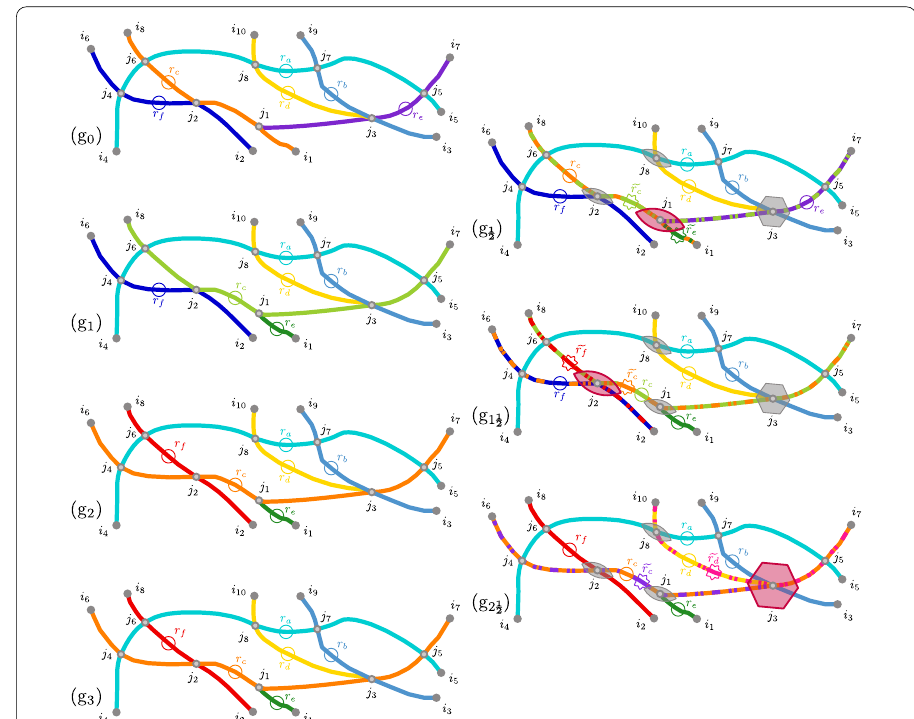
Fig. 5 Single-junction-switch Metropolis algorithm for configurations of streets: the frames ( g ⋆ ) show how this algorithm may evolve from the configuration of streets on street map ( m ′ ) to the one on street map ( m ) from the notional example in Fig. 1. The subscript of each frame label indicate the generation time. The figure reads from top to bottom. It actually separates generated configurations of streets from intermediate computational steps in two complementary ways: it shifts (resp. epochs) the formers to the left column (resp. with integers) and the latters to the right column (resp. with half-integers). The right frames display more information. In particular each switchable junction is marked with an extended regular polygon whose the corners (sides) enumerate its maximum matchings (see Fig. 4): when the polygon is in grey, the junction is resting; when the polygon is in red and notably bigger, the junction is switching. As for the state-of-the-art construction paradigm in Fig. 3, we attribute to each street a particular colour. In clear contrast, however, all streets are here fully constructed. The streets in dashed lines are not under construction but instead under challenge as follows. The dashing actually indicates coexistence of old streets with new ones. Each old street keeps its colour, its circle mark, and its label. Each new street emerges with a new color, a wavy-circle mark, and a tilded label. The new streets result from the new street layout at the switching junction. This change leads so to a new configuration of streets ν that competes with the old one µ . This is the actual ongoing challenge. The Metropolis algorithm resolves such challenges by either accepting or rejecting change µ → ν with an acceptance ratio A (µ → ν) in an optimal way. After a sufficient number of generations, the configurations of streets reach a prescribed statistical equilibrium—provided the equilibrium is sustainable. Our prescribed statistical equilibrium follows from the assumption that self-organized urban street networks are statistically self-similar. It is a Boltzmann-like distribution with a total amount of surprisal (information) instead of energy and the scaling as equilibrium parameter (see formula (16)). Our odds of accepting or rejecting new configurations of streets favour the less surprising ones (see formulae (23) and (30)). The algorithm goes like this (see “Informal implementation” section). Note first that only the four junctions j 1 , j 2 , j 3 , and j 8 are actually switchable: junction j 3 has Y 3 = 6 maximum matchings (see Fig. 4c); junctions j 1 , j 2 , and j 8 have Y 1 = Y 2 = Y 8 = 2 maximum matchings (see Fig. 4a, b); the remaining junctions j ◦ have obviously Y ◦ = 1 maximum matching. So each move will first choose randomly one junction among junctions j 1 , j 2 , j 3 , and j 8 with probabilities 1 and